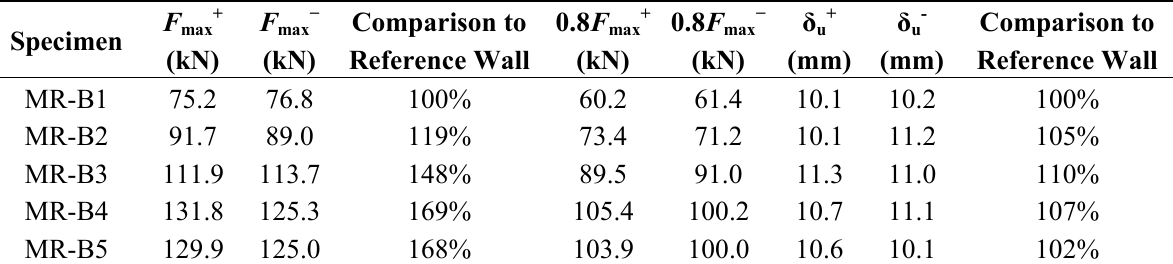
Table 4. Horizontal force and maximum displacement at the top of the wall in Series MR-B.